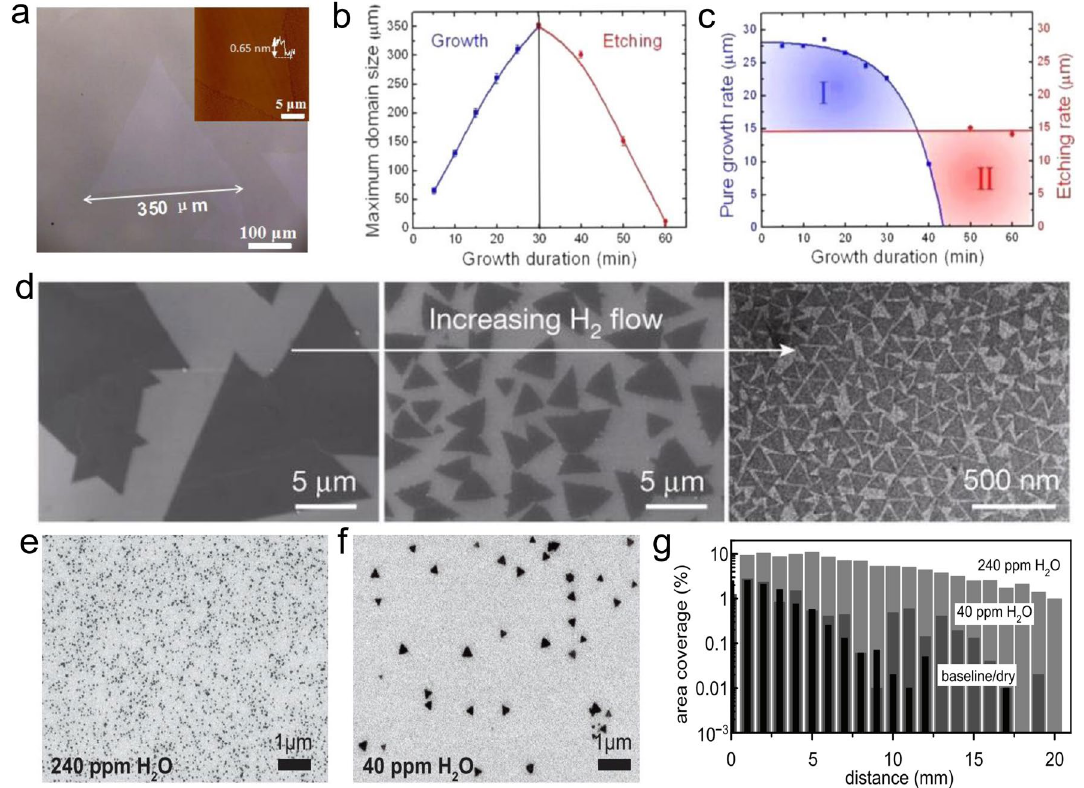
Fig. 6 The effect of the used atmosphere. a – c Using oxygen mixed Ar as the atmosphere [90], Copyright 2015, American Chemical Society. d Using H 2 mixed Ar as the atmosphere [47], Copyright 2015, Springer Nature. e – g Using H 2 O mixed Ar as the atmosphere [91], Copyright 2017, Institute of